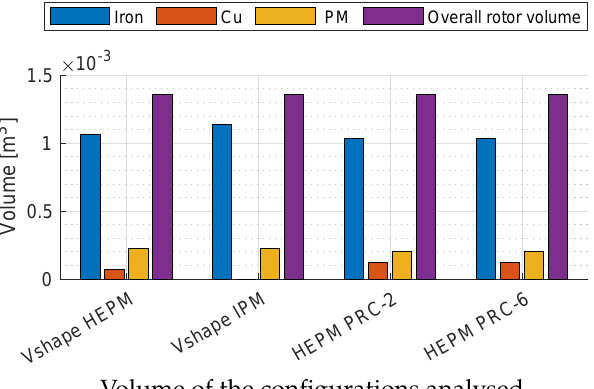
Figure 15. Volume of iron, copper, PM and overall of the raw